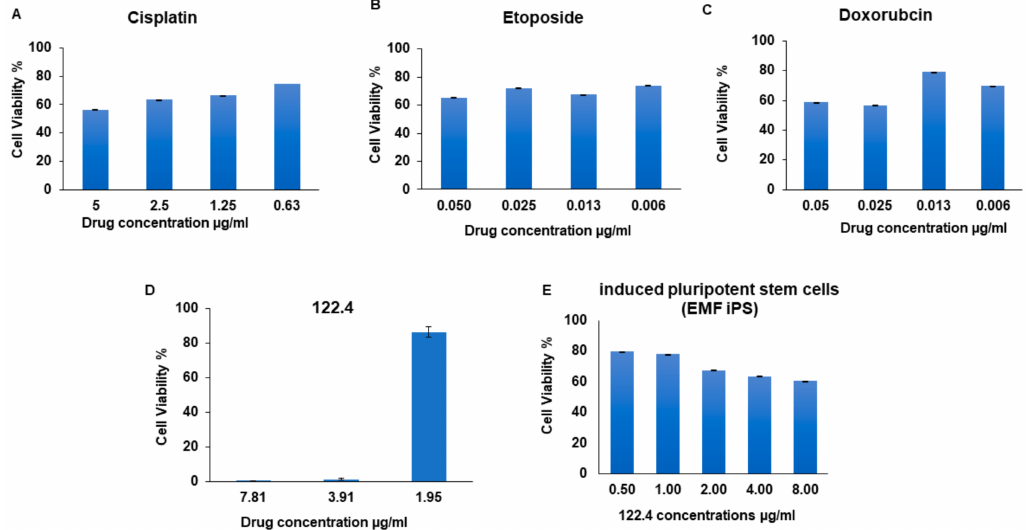
Figure 1. The effects of treatment with A. graveolens fraction 122.4 or several chemotherapeutic drugs on BS-24-1 cells and human induced pluripotent stem cells (iPSCs). A–C, cytotoxic effects of cisplatin, etoposide and doxorubicin on BS-24-1 cells, respectively. D and E, cytotoxic effects of 122.4 on BS-24-1 cells and iPSCs, respectively. iPSCs cells were plated at a concentration of 500,000 cells/mL and incubated with fraction 122.4 for 72 h; the results are presented as the means ± SD and are representative of three independent